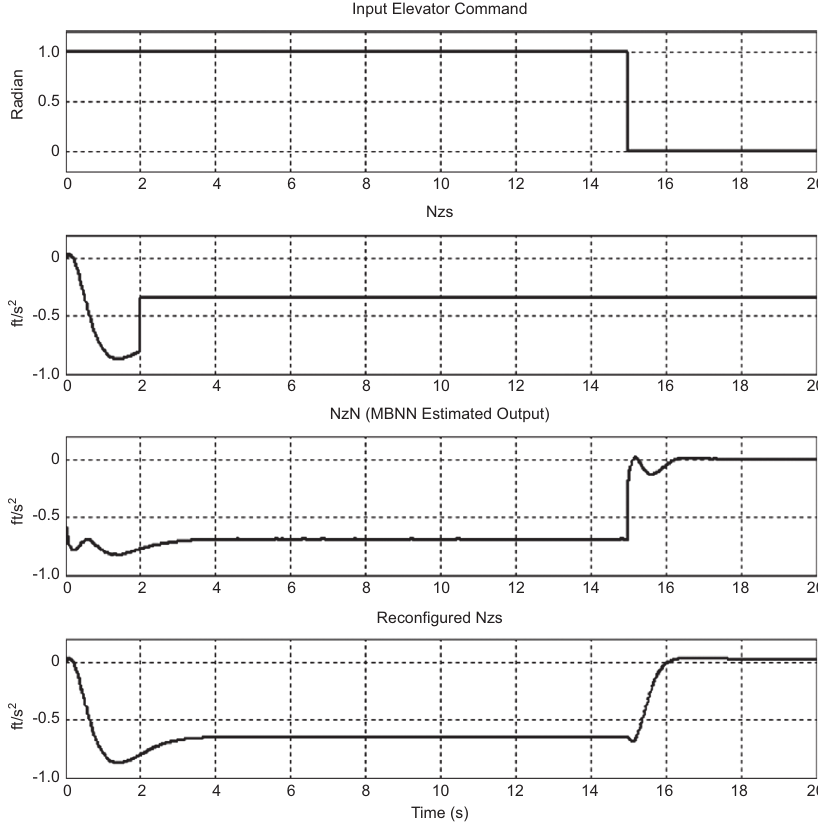
Figure 10. SFDA Stuck Sensor Fault of “–0.35” at 2